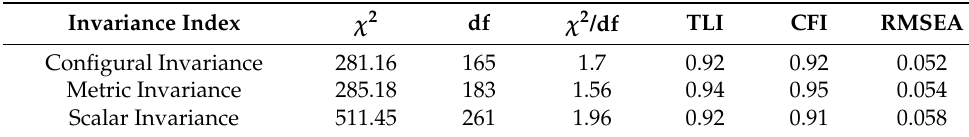
Table 5. Results of the invariance